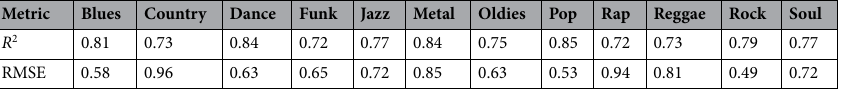
Table 3. Prediction results using position data for twelve STOMP based musical preference (Blues, Country, Dance, Funk, Jazz, Metal, Oldies, Pop, Rap, Reggae, Rock, and Soul) using bayesian regression on Dataset-1.